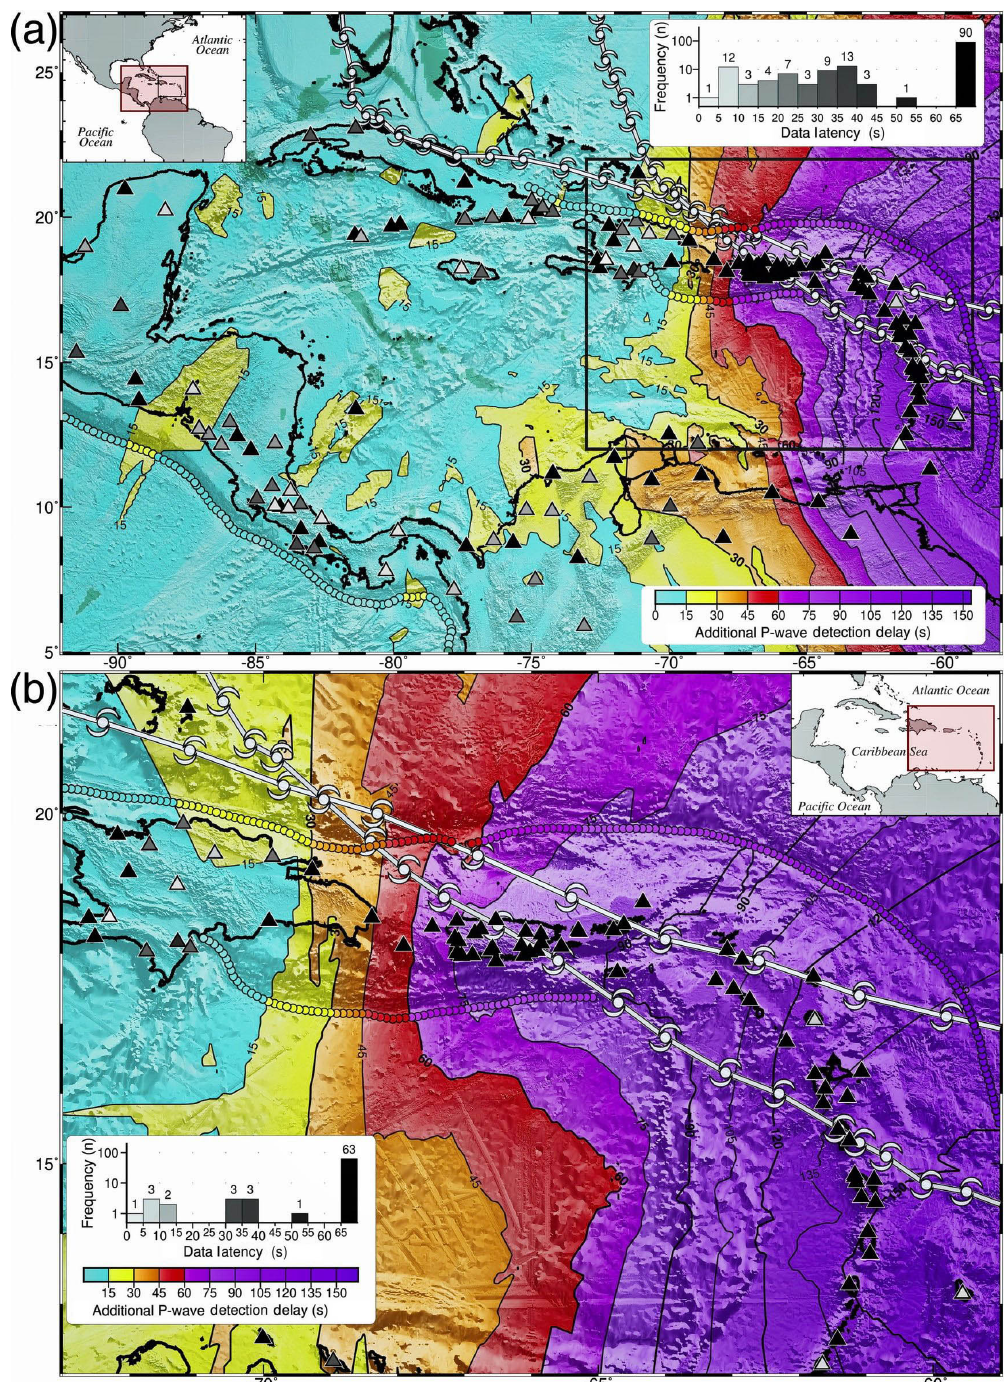
Figure 7. Impact of hurricanes Irma and Maria on the detection time of the first arriving P wave at a minimum of eight stations in the Caribbean after (a) subtracting the median P wave detection times shown in Fig. 1b from those in Fig. 6a and (b) zooming into the rectangular area monitored by the PTWC local processing system for the Caribbean. The hurricanes caused additional P wave detection delays of more than 15s across 43% of the Caribbean region. Within the eastern Caribbean shown in (b) , however, additional P wave detection delays of more than 15s affect 88% of the total area, with delays of 60–163s (01:00–02:43) affecting 51% of the eastern half of the area. The small, contiguous circles show the computed P wave detection delays sampled every (a) 25km and (b) 10km along the trench axes. White vortex tracks show the paths of hurricanes Irma to the north and Maria to the